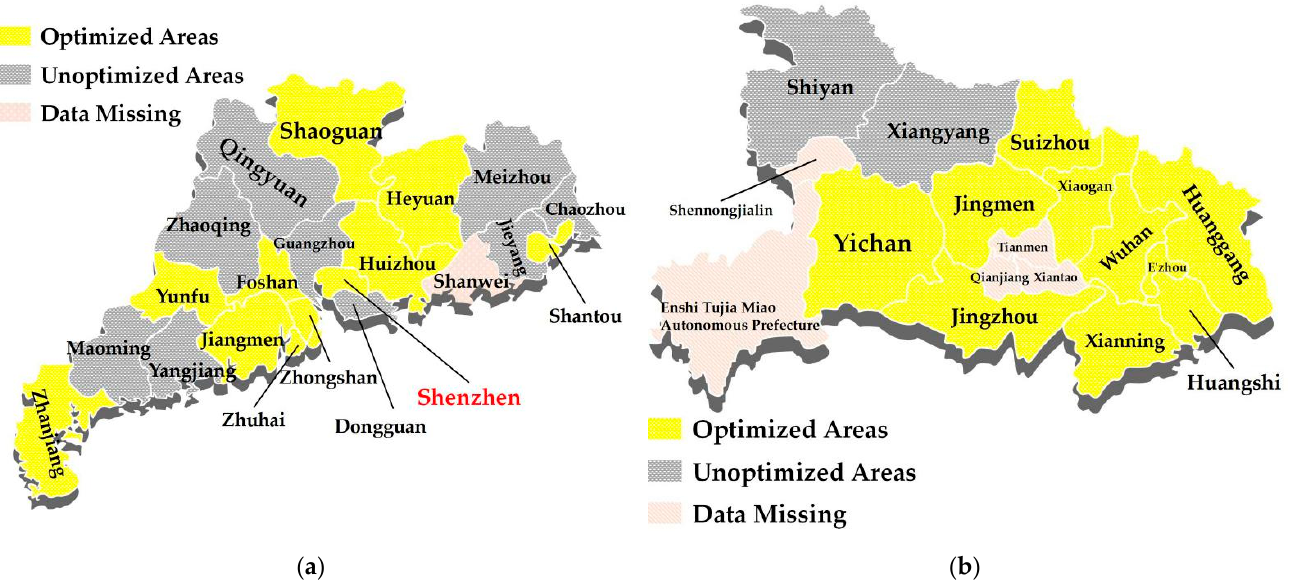
Figure 4. Spatio-temporal Evolution Pattern of LUE_Env. ( a ) Guangdong Province. ( b ) Hubei Province.